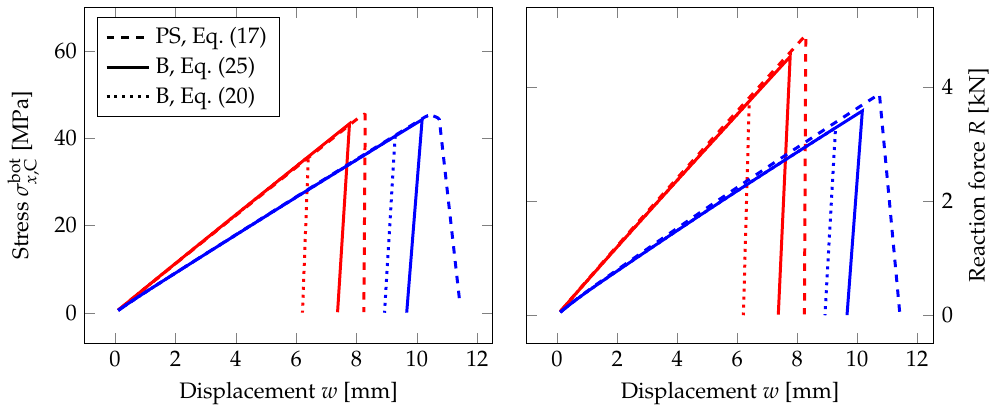
Figure 20. PF-P formulation, anisotropic staggered approach with the spectral-decomposition split: Comparison of the response of laminated glass plates with EVA (red line) or PVB (blue line) using the plane-stress (PS) or beam formulation (B). The evolution of the largest tensile stress at the midpoint and the overall reaction under the loading points for the mid-span displacement. The bending strength of glass is set to 45